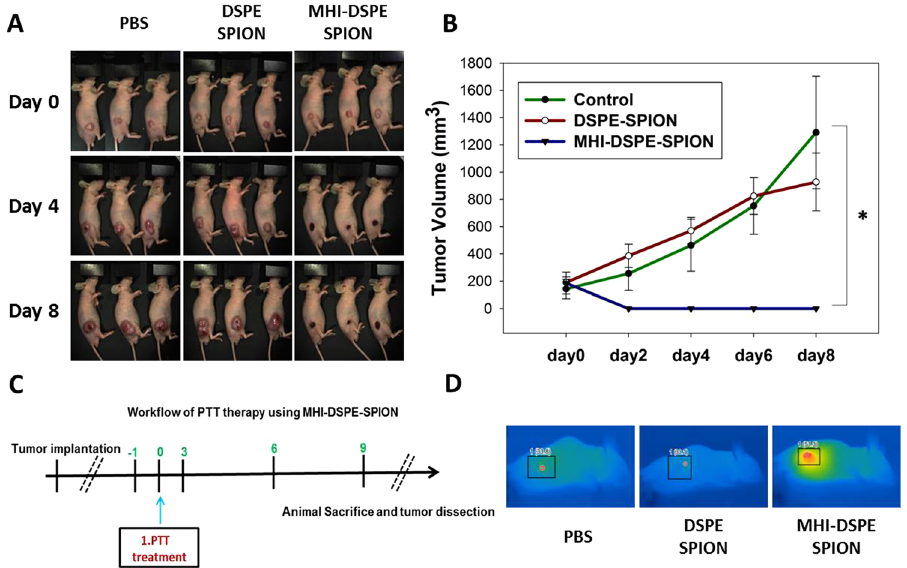
Figure 13. Photothermal mediated tumor reduction study. ( A ) Mice injected with 50 µ L PBS, DSPE-SPION (10 mg[Fe]/kg) and MHI-DSPE-SPION (10 mg[Fe]/kg) plus further laser irradiation. ( B ) Tumor growth curves of PBS, DSPE-SPION and MHI-DSPE-SPION. ( C ) Workflow depicting PTT. ( D ) Infrared photothermal images of mice tumor (inset), * P < 0.05 relative to PBS-injected group (n =